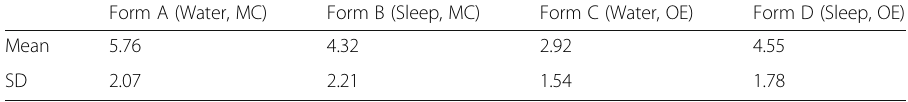
Table 5 Descriptive statistics of test